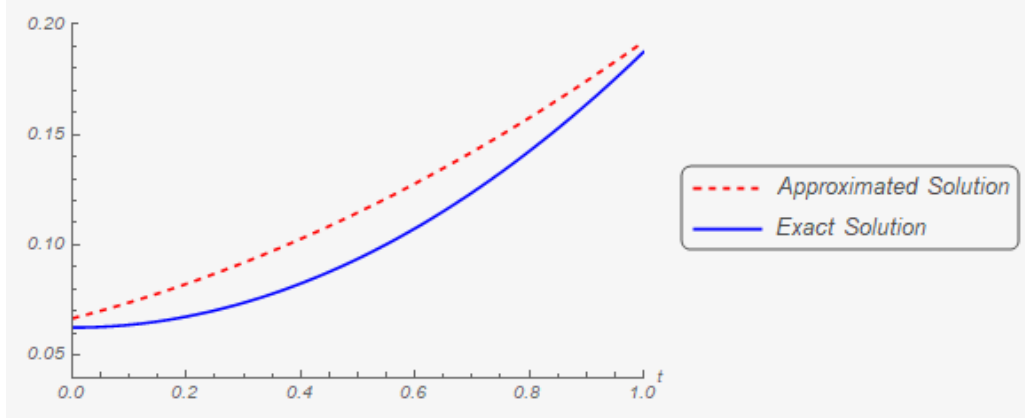
Figure 3. The first component of the exact solution and its fifth approximation.